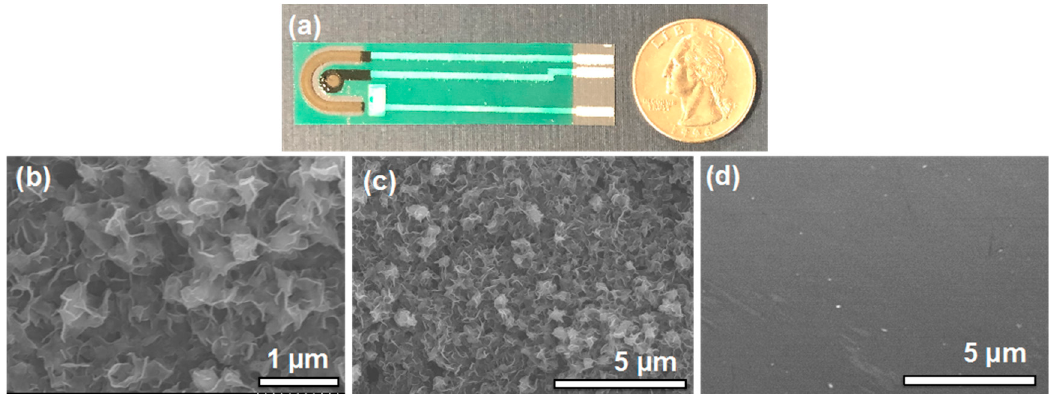
Figure 3. Optical image of the fabricated sensor ( a ) SEM images of a Bi-chitosan nanocomposite film at ( b ) 30 k magnification and ( c ) 10 k magnification, and ( d ) SEM image of a bare carbon electrode at 10 k magnification.